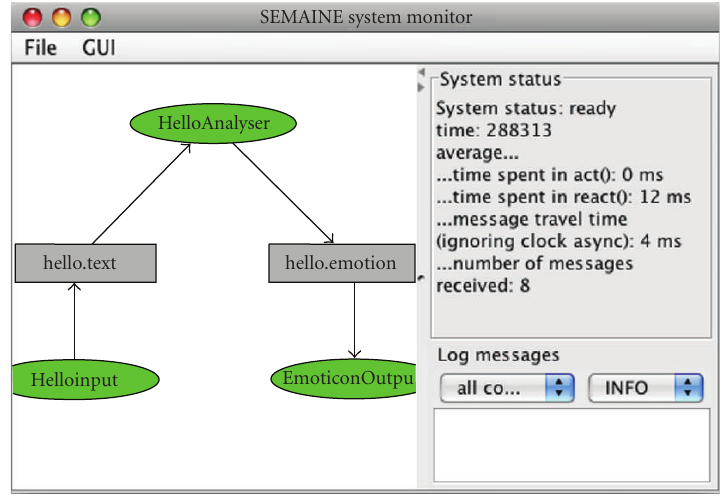
Figure 16: Message flow graph of the Hello system.